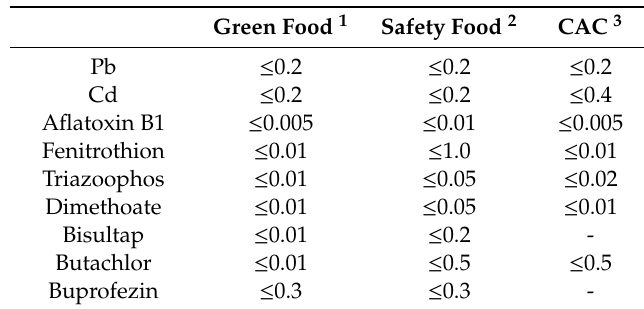
Butachlor ≤ 0.3 ≤ 0.3